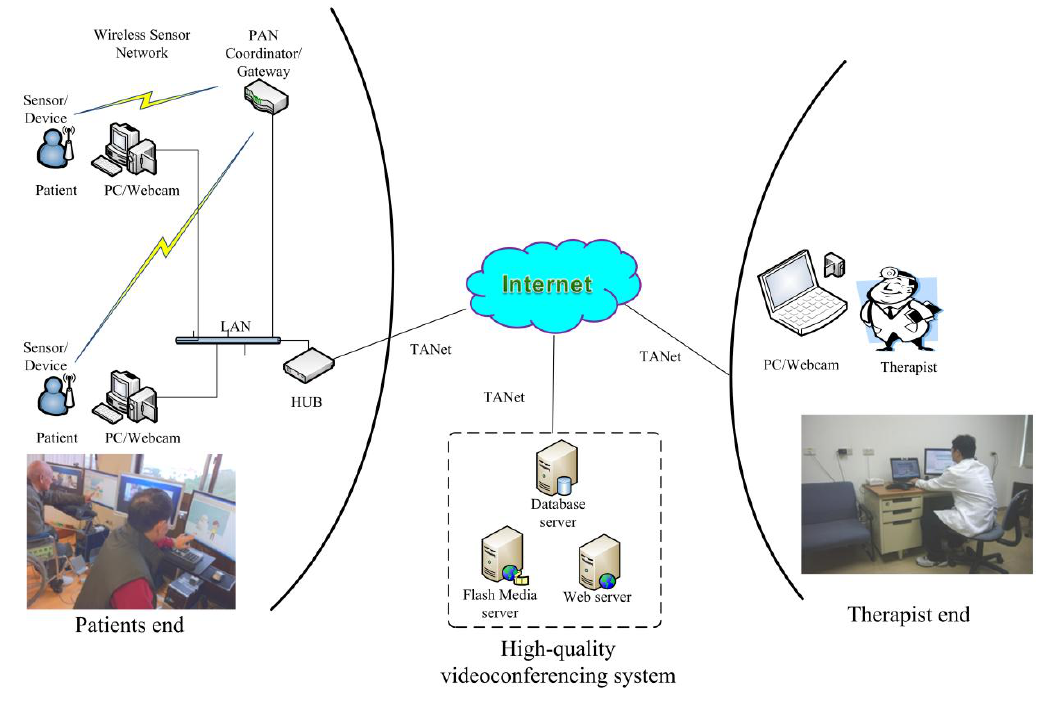
Figure 1. Architecture of the designed WSN telerehabilitation